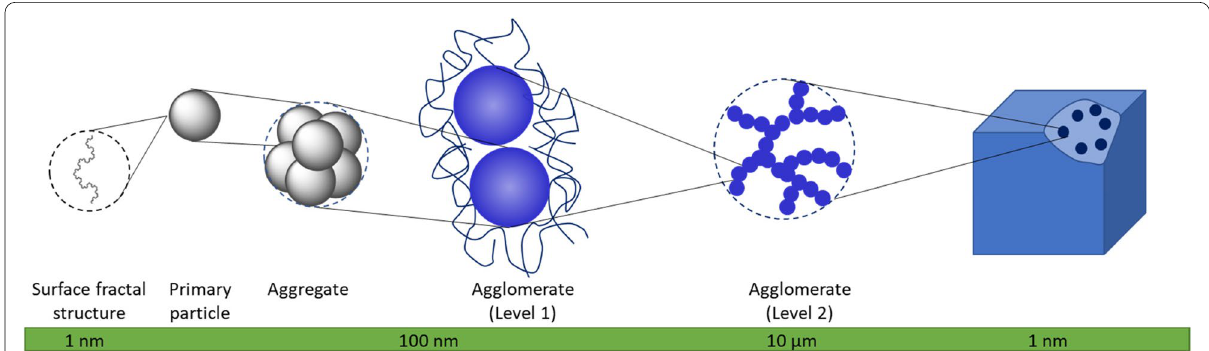
Fig. 4 Schematic model for the hierarchical structure of the filler in the rubber matrices